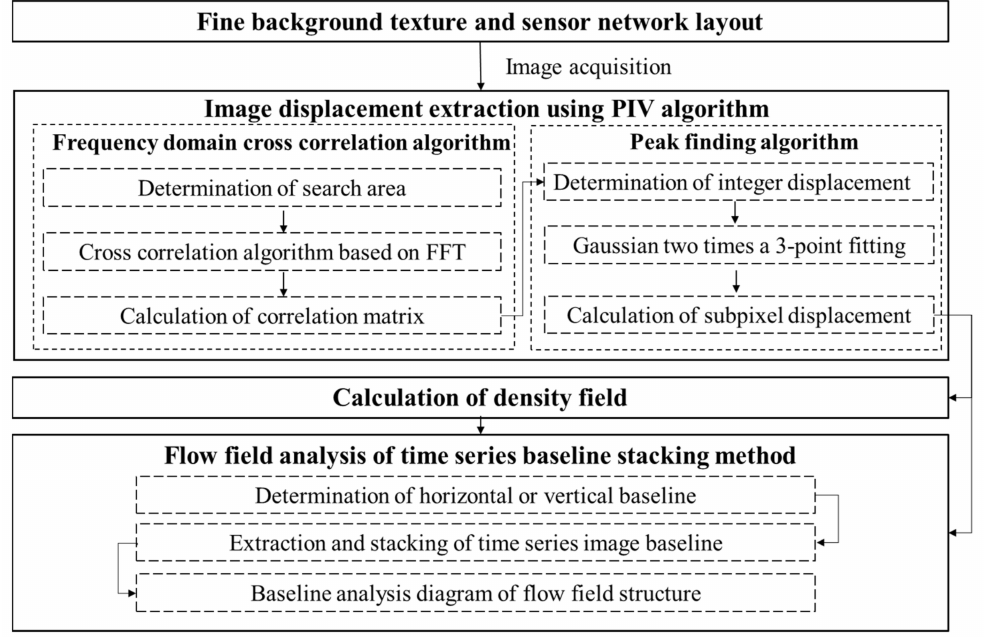
Figure 2. Framework of the entire